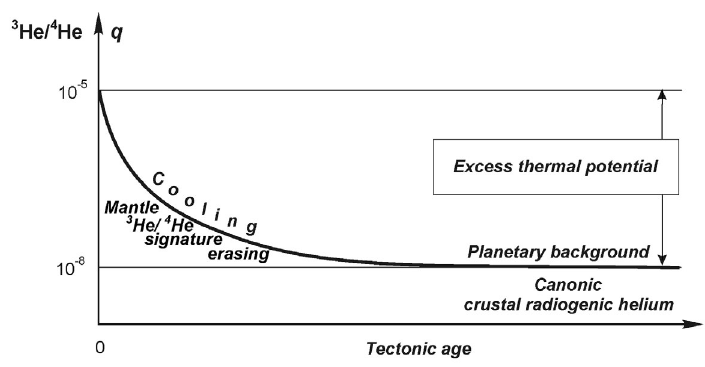
Fig. 5. The q-t - 3 He/ 4 He triple relationship. See explanation in the text.